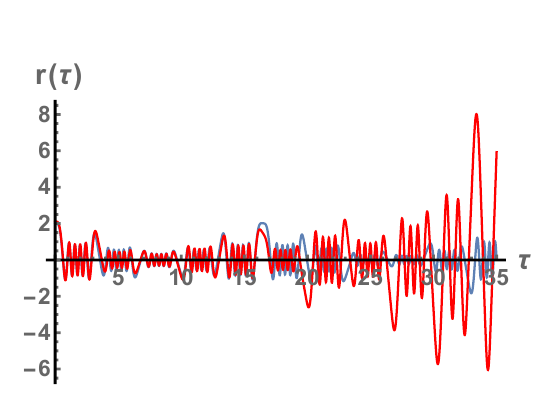
Figure 2 . The evolution of the strings along the direction r for the same initial conditions as in (cid:12)g- ure 1. Notice that the negative values of r ( (cid:28) ) and R ( (cid:28) ) correspond to radii of j r ( (cid:28) ) j and j R ( (cid:28) ) j with changed string orientation comparing to the pos- itive values. Both plots have N f =N c (cid:24) 0 : 3 ; (cid:21) = 12, where the values have chosen for best optical results. Higher values of N f =N c give a similar pat- tern and make the chaotic oscillations more severe and observed at earlier